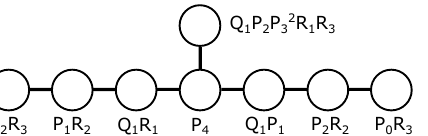
on ( − 5) -curve in figure 40(a). 7